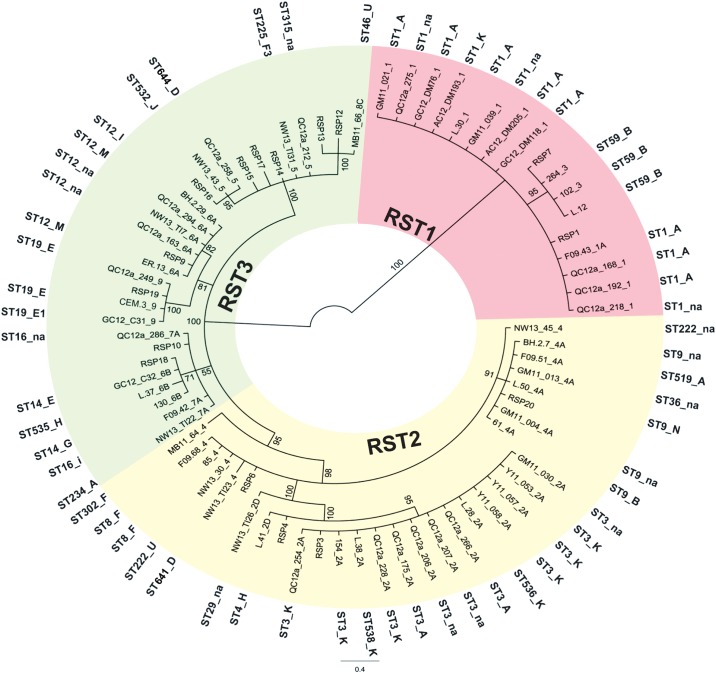
An unrooted Bayesian maximum likelihood tree of ribosomal 16S-23S rrs-rrlA IGS spacer sequences.The tree was constructed using the 80 samples for which these sequences were available, as well as reference sequences described in the text. Identification numbers of the samples and the IGS type number are shown on the tree. The correspondence of these sequences to RST types is shown by colour coding (RST1: dark pink; RST2: light pink; RST3: gray). Around the colour-coded areas are the corresponding ST numbers and ospC major groups of the samples (na = data not available).